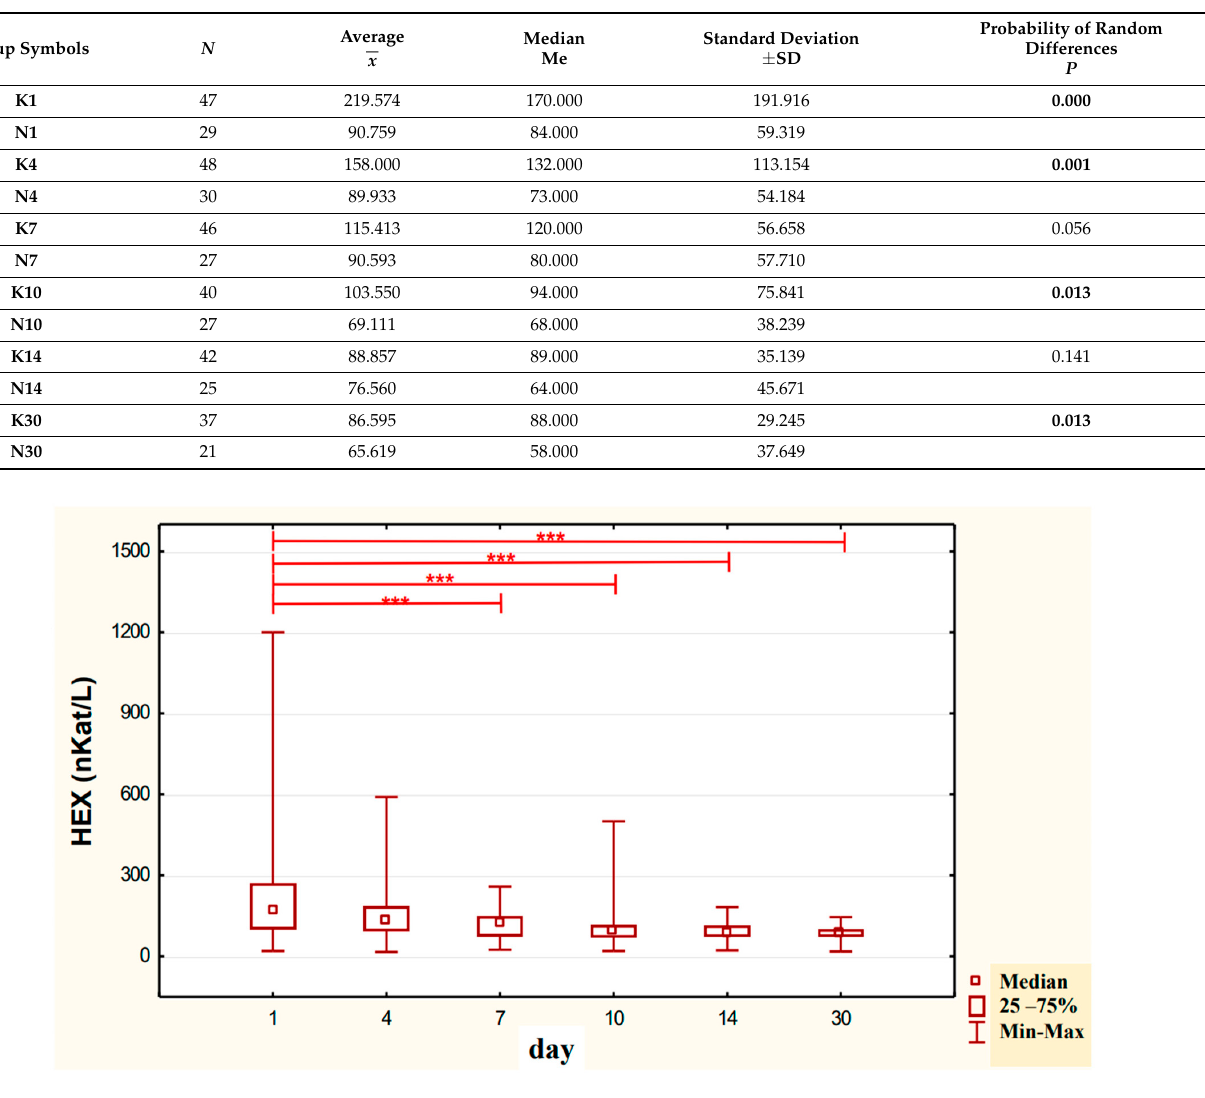
Figure 4. Variability over time in the concentration of urinary HEX activity (nKat/L) of control group patients addicted to alcohol but not treated with neoglandin (K); *** p <